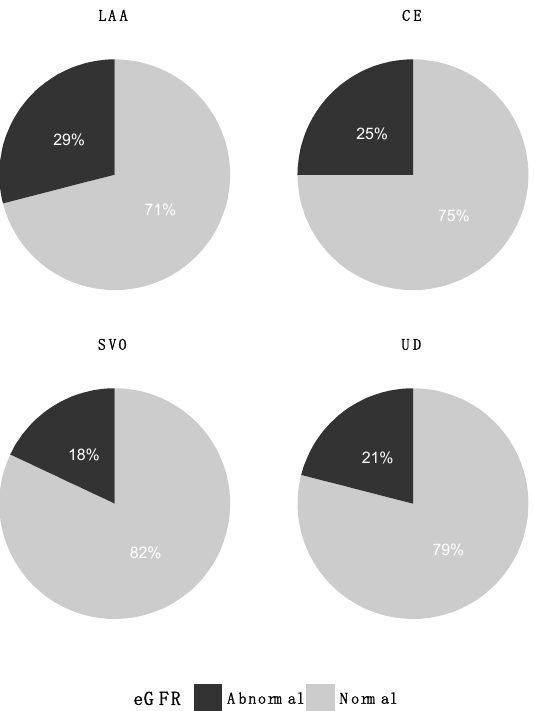
Figure 5. Distribution of abnormal eGFR (<60 mL/min/1.73 m 2 ) across TOAST groups. CE: cardioembolism; LAA: large artery atherosclerosis; SVO: small vessel occlusion; UD: undetermined etiology.